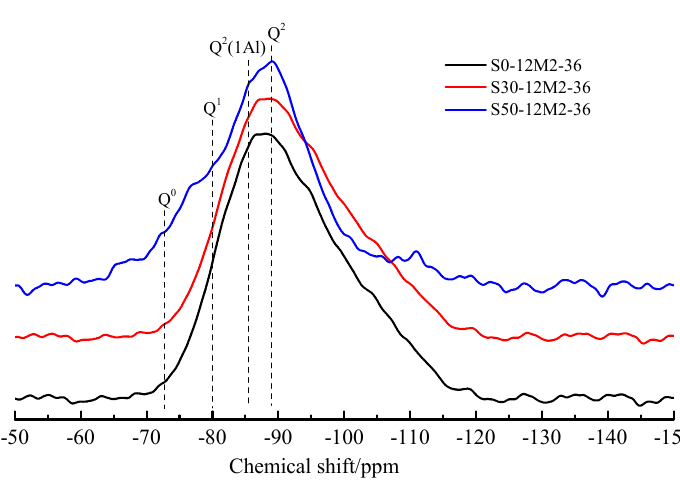
Figure 9. 29 Si MAS-NMR spectra for AACGS samples.